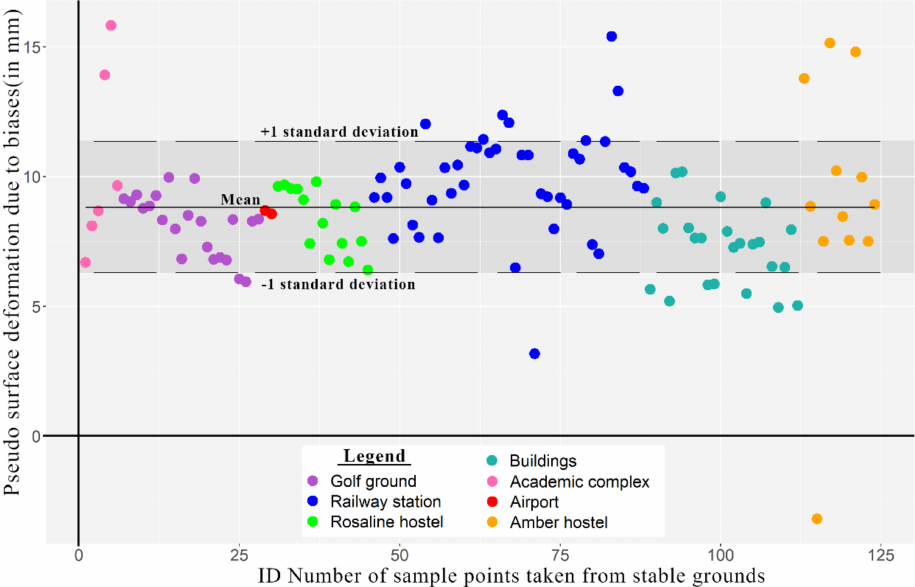
Figure A2. Graph showing the bias value identified in 125 points locations that are geologically stable. Different colors are given to the sample points according to the asset from where it is taken. The mean bias and standard deviations are also shown in the plot.